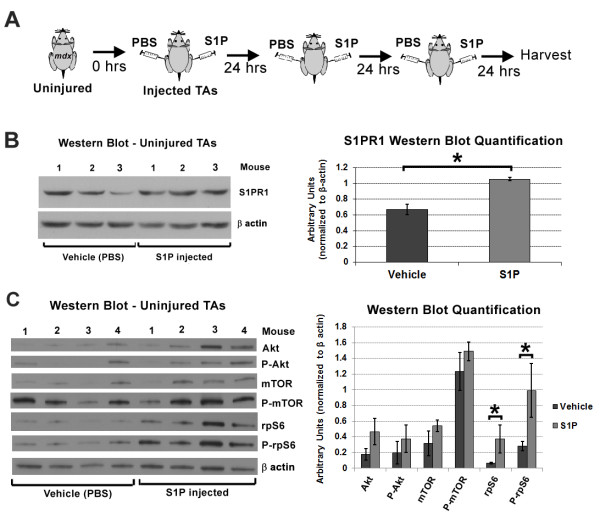
Administration of S1P leads to increased levels of S1PR1 and P-rpS6 in vivo. (A) Experimental schematic of S1P and PBS (vehicle) injected daily for the first 72 hours into TAs of uninjured mdx4cv mice (n = 4, 2.5-MO, left TAs injected S1P, right TAs injected PBS). (B) Western blot analysis of injected TAs (n = 3, 2.5-MO mdx4cv) indicates that administration of S1P significantly increases S1PR1 levels. (C) Western blot analysis of injected TAs (n = 4, 2.5-MO mdx4cv) for total, and P-Akt, P-mTOR and P-rpS6, reveals that total and P-rpS6 were significantly higher with S1P treatment. Increased levels of total and P-rpS6 suggest that S1P administration promotes protein synthesis in mdx muscles. *P <0.05 by student’s t-test. Error bars represent SEM. MO, month-old; P-Akt, phosphorylated Akt; P-mTOR, phosphorylated mammalian target of rapamycin; P-rpS6, phosphorylated ribosomal protein S6; rpS6, ribosomal protein S6; S1P, sphingosine-1-phoshate; S1PR1, S1P receptor 1; SEM, standard error of the mean; TA, tibialis anterior.